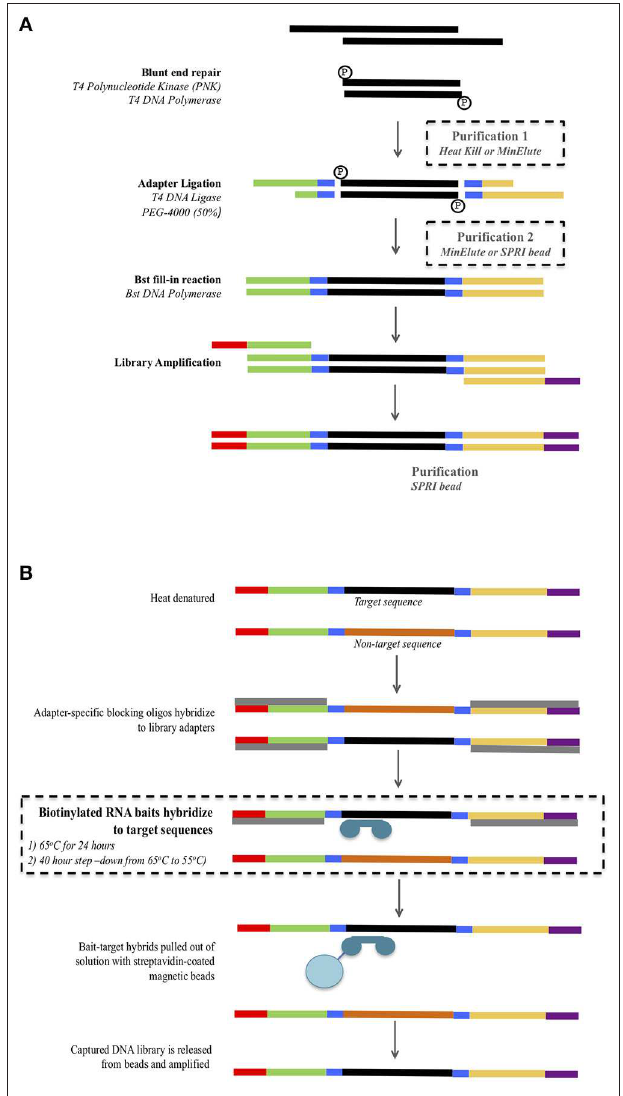
FIGURE 1 | Overview of the library preparation (A) and mtDNA hybridization enrichment (B) protocol. Modifications to the protocol are highlighted inside dashed boxes. For the library preparation (A) three combinations of purification 1 and 2 were tested: Minelute + Minelute; Heat Kill + MinElute; and Heat Kill + SPRI